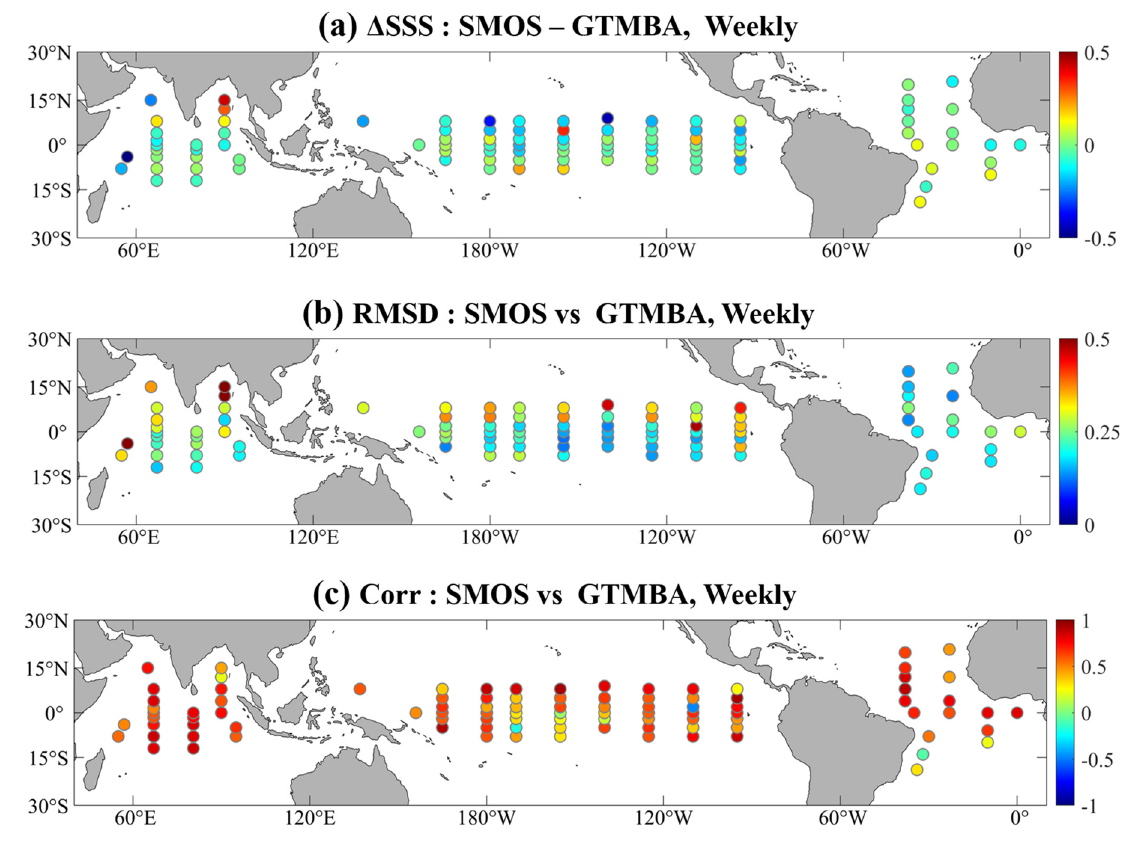
Figure 12. Comparison of SMOS SSS with salinity measured by GTMBA buoys at 1m depth at weekly scale in terms of ( a ) ∆ SSS, ( b ) STD and ( c ) correlation coefficient. The time range was from 1